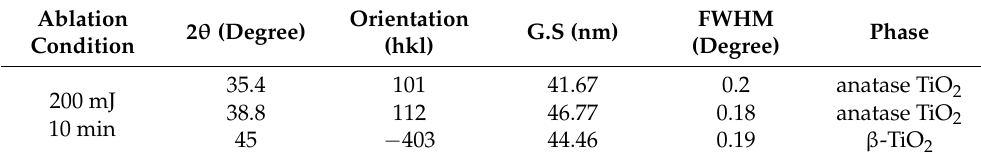
Figure 5. XRD patterns of TiO 2 NPs. Table 1. XRD parameters of TiO 2 NPs.